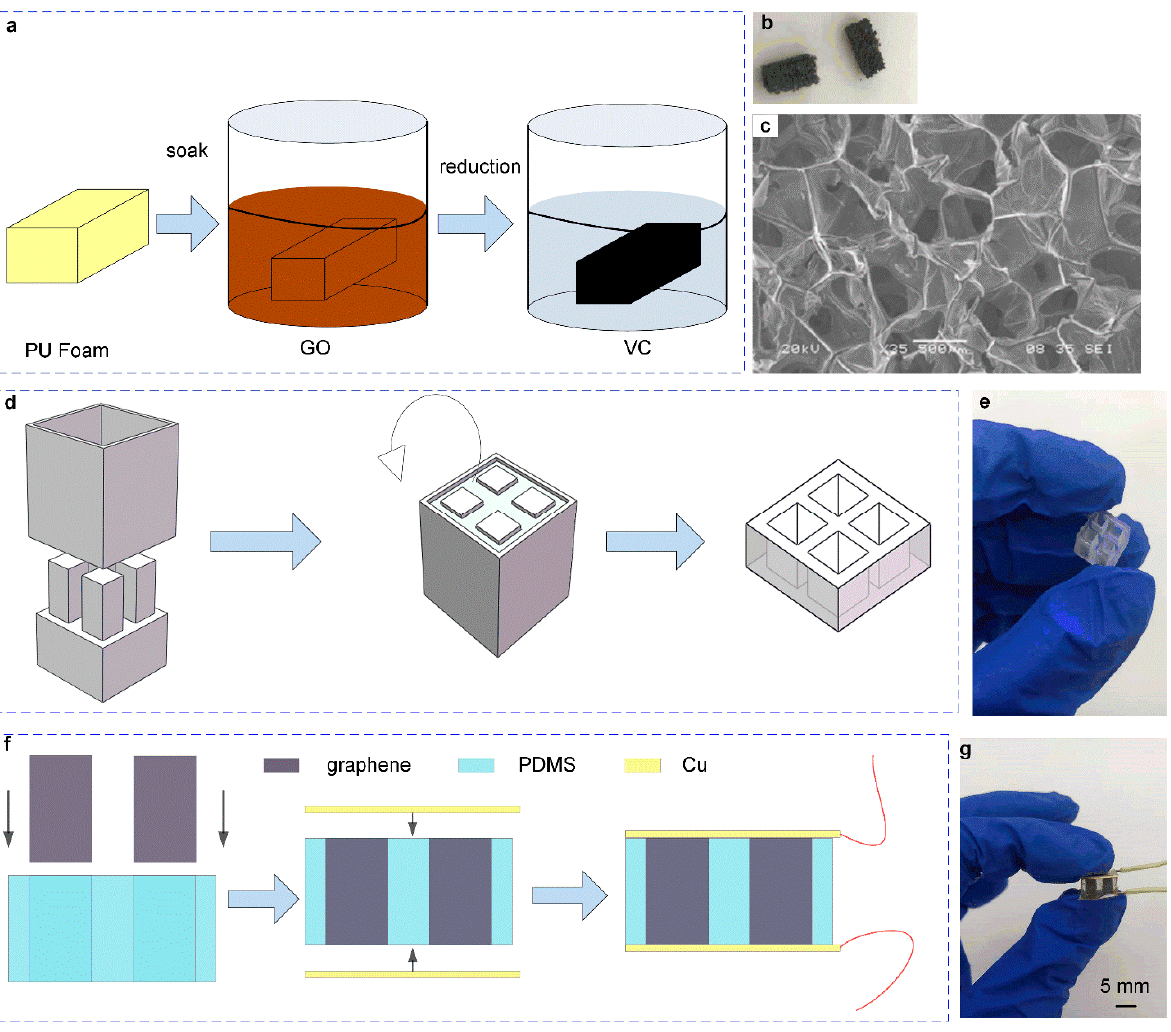
Figure 4. The fabrication processes of the pressure sensor. ( a ) The fabrication processes of the graphene foam. ( b ) The photo of fabricated graphene foam. ( c ) The plane view SEM image of prepared 3D graphene foam. ( d ) The fabrication processes of the support structure of the pressure sensor. ( e ) The photo of the fabricated support structure. ( f ) The fabricated processes of the pressure sensor. ( g ) The photo of the fabricated pressure sensor.